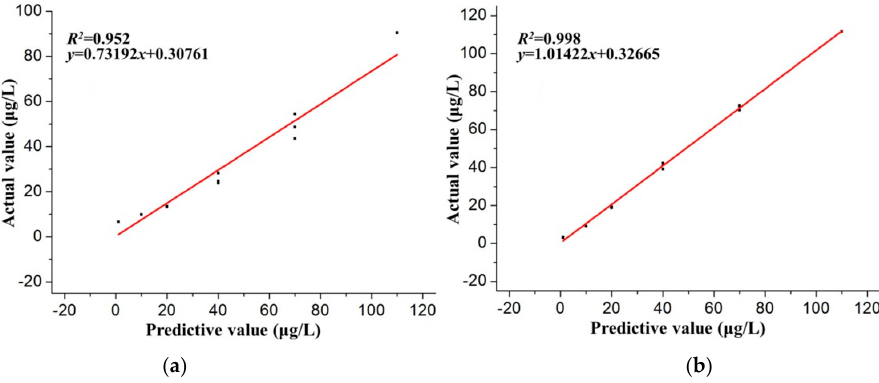
Figure 8. Linear regression analysis of the prediction results obtained from ( a ) the direct calibration model and ( b ) the ANN model. Table 4. The statistical parameters of the direct calibration model and BP-ANN model.